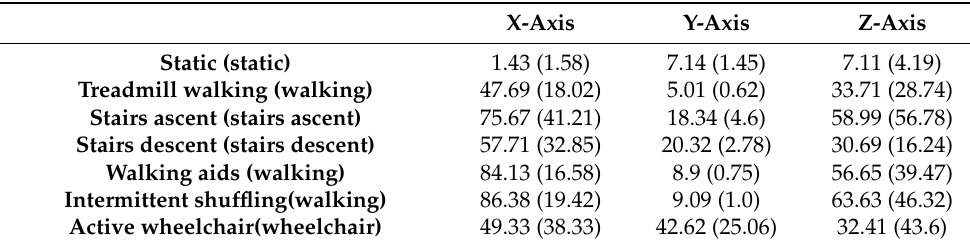
Table A1. Median and IQR of false negative percentages according to different activity groups.